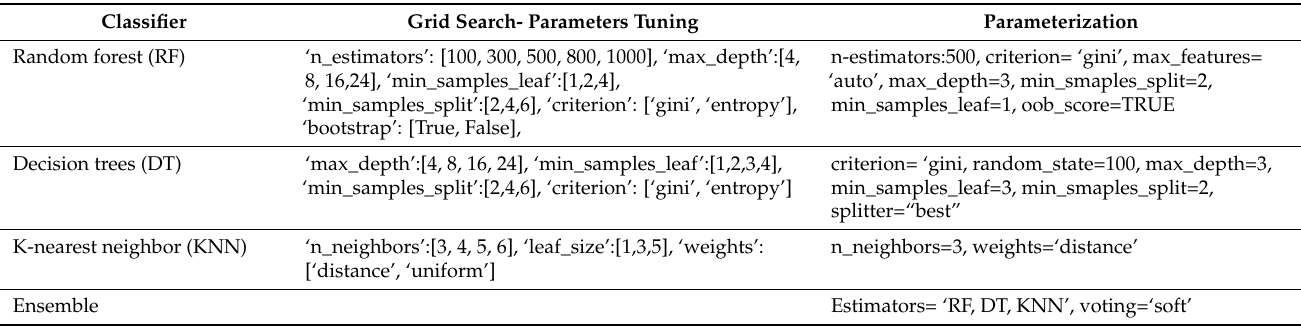
Table A1. Classifiers and parameterization performed during the run of supervised classifications with the multiple ensemble classifier approach.